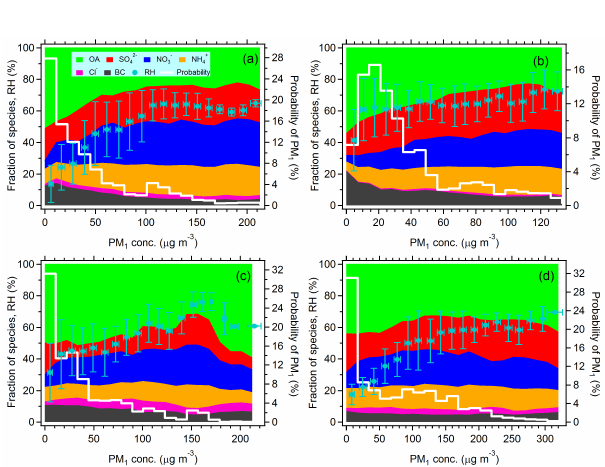
Figure 2. Fractions of main chemical compositions in submicron aerosols at different PM 1 levels, and the probability density of PM 1 (white curves) during the spring (a) , summer (b) , autumn (c) , and winter (d) observations. The average RH values in each segment are illustrated and the error bars in the x and y axis were the standard deviations of PM 1 and RH,